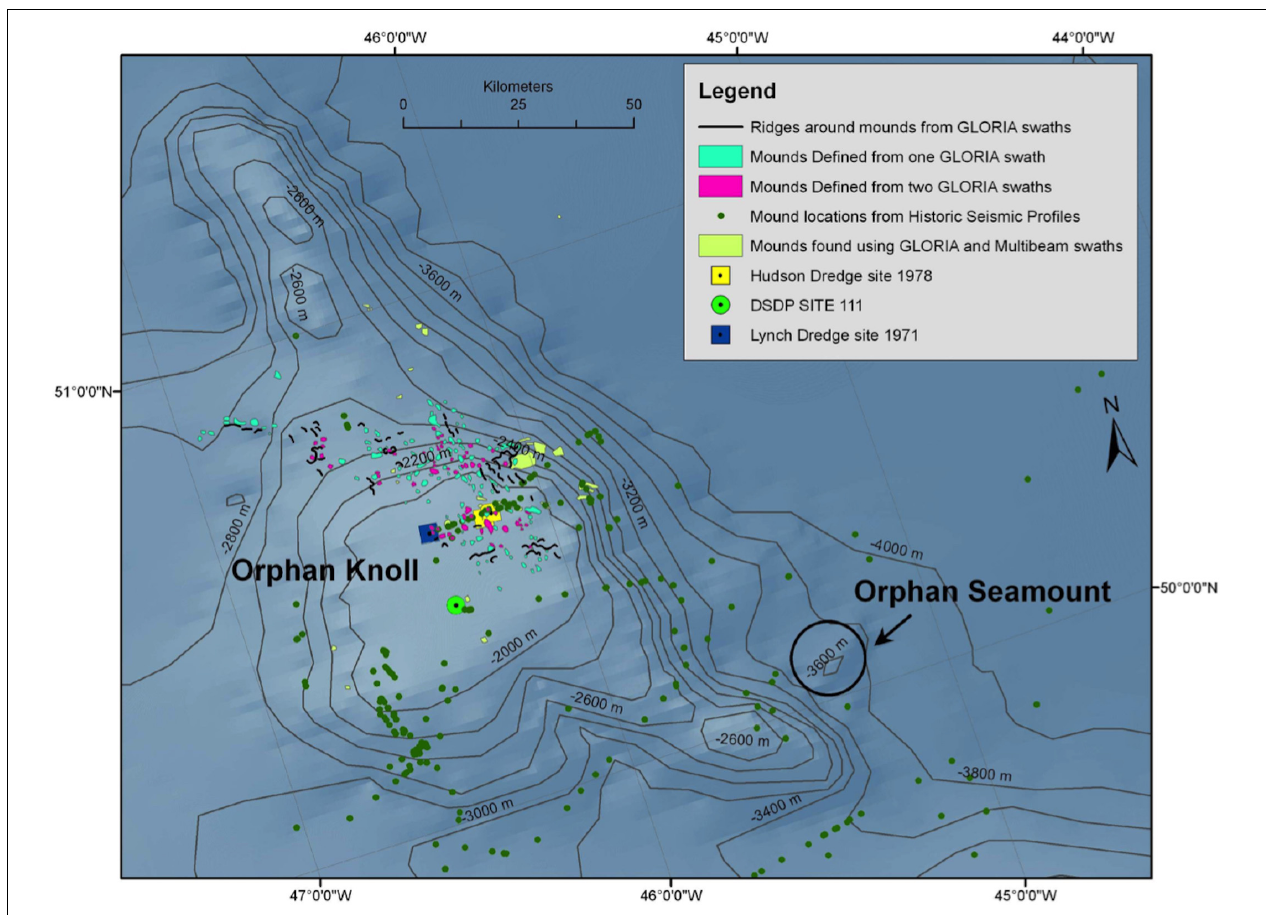
FIGURE 3 | Compilation of mound occurrences from GLORIA side-scan sonar, USCG Healy and Kommandor Jack multibeam sonar. Green dots represent positive relief features from various legacy Geological Survey of Canada sub-bottom profile data. The apparent alignment of positive relief features from historical seismic profiles is an artifact of linear data acquisition. Orientation and distribution of the various datasets contributing to this figure are presented in Supplementary Material